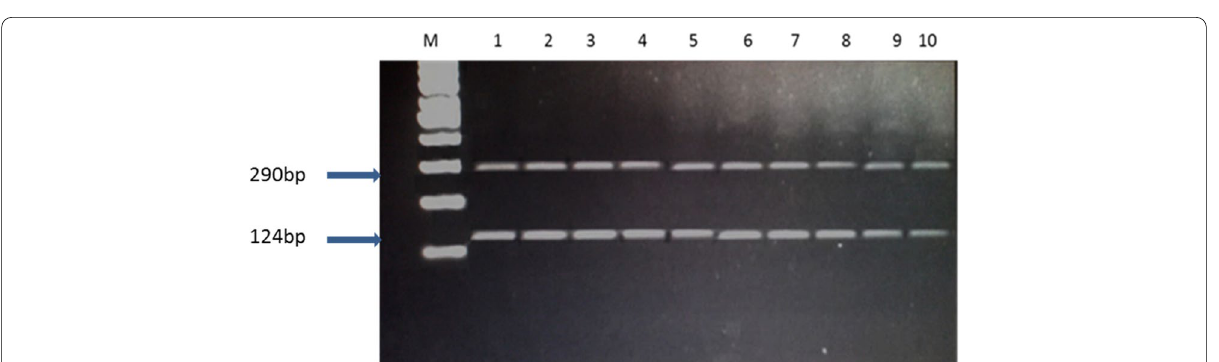
Fig. 7 PCR‑RFLP fragment of BMP4 gene, M: 100 bp ladder, lanes 1–10: fertile and repeat breeder